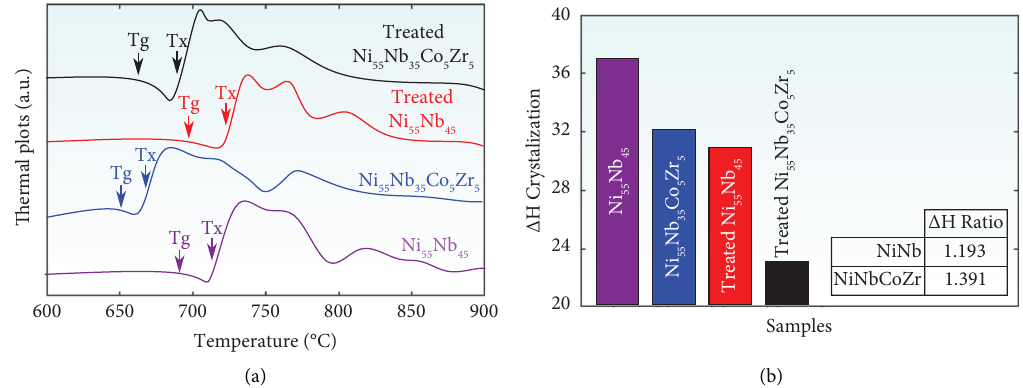
Figure 2: (a) thermographs of samples in the crystallization region for raw and treated samples, (b) enthalpy of crystallization for the samples.